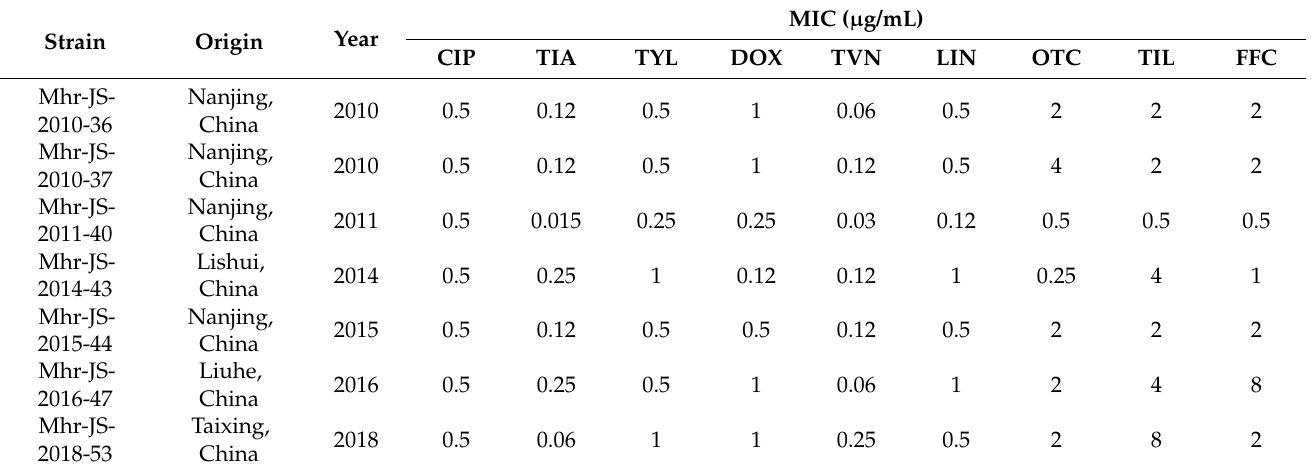
Table 1. The background information and MIC data of the seven ciprofloxacin-sensitive M. hyorhinis isolates used for in vitro selection.